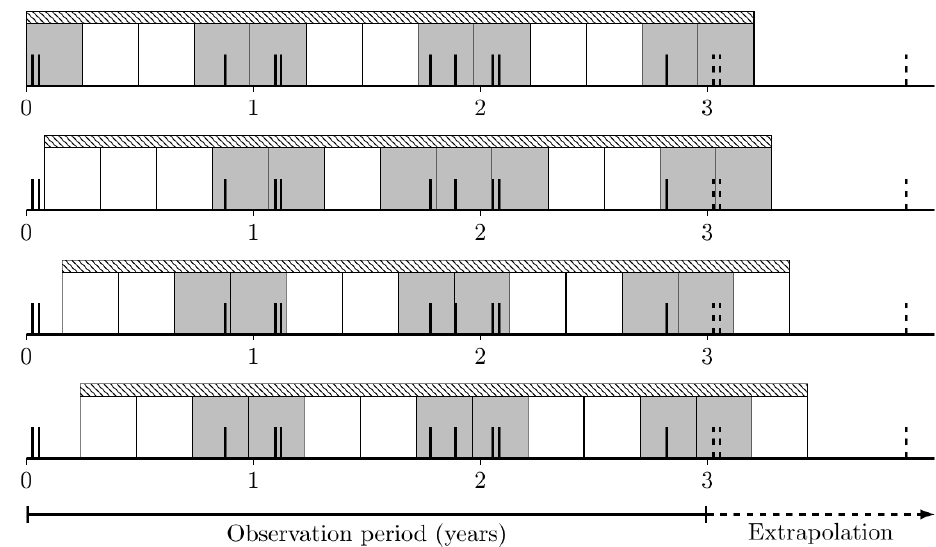
Figure 7. Shifted intervals to minimize the impact of events near the interval boundaries. Events are shown as bold black vertical bars. Gray intervals contain events and white intervals contain no events. The shaded bar shows the time scale analyzed.